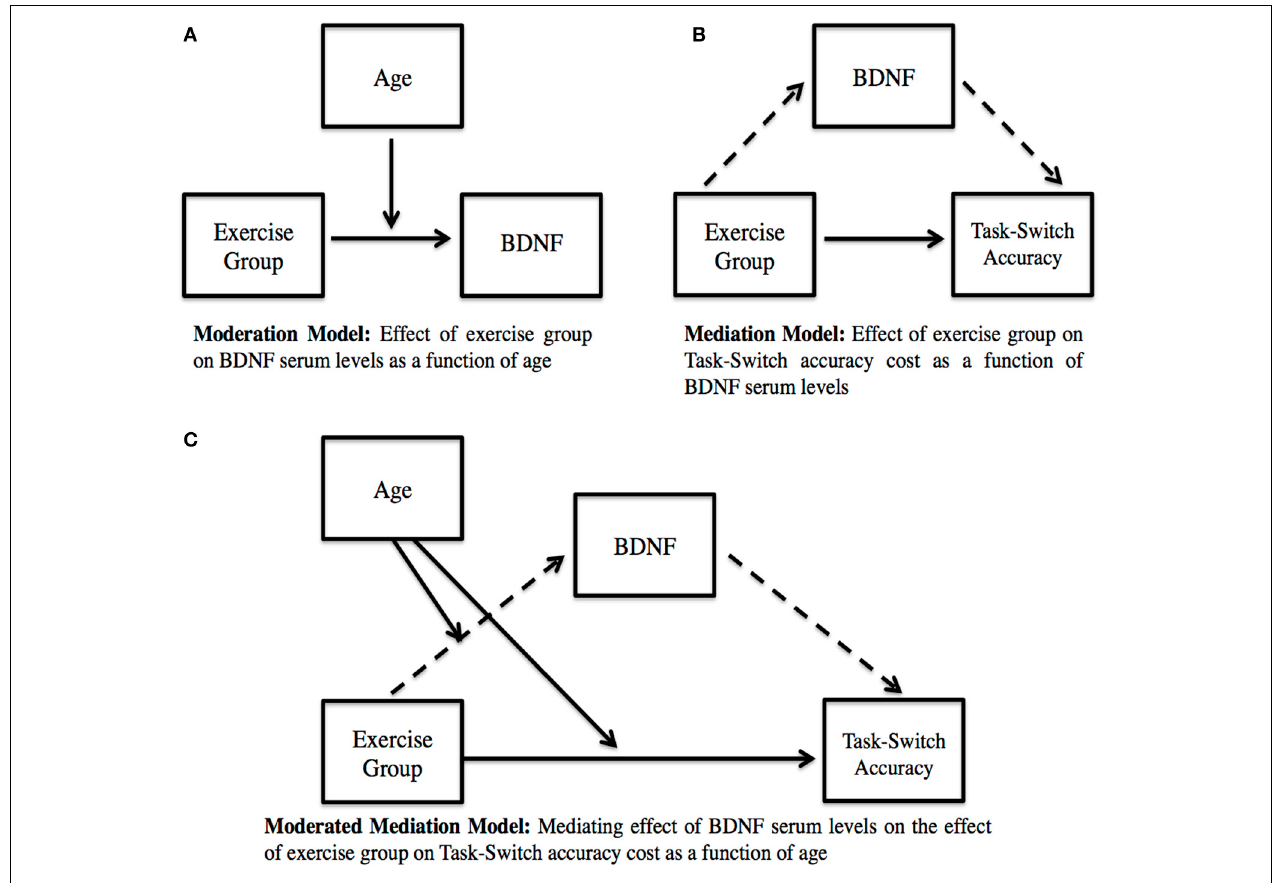
FIGURE 2 | Moderated mediation model. (A) Moderation Model: Effect of exercise group on BDNF serum levels as a function of age. (B) Mediation Model: Effect of exercise group on Task-Switch accuracy cost as a function of BDNF serum levels. Note: Solid arrow indicates direct pathway; Dashed